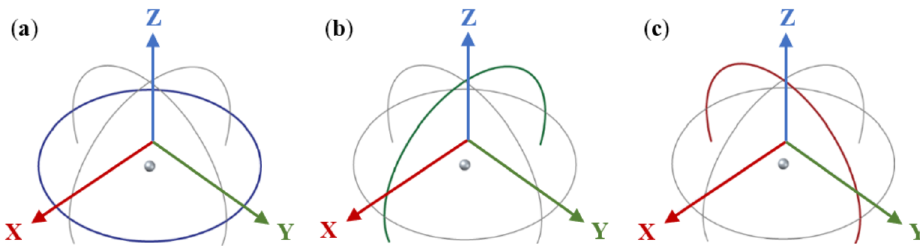
Figure 2. Circular paths in individual planes for volumetric analysis. ( a ) plane XY; ( b ) plane ZX; ( c ) plane